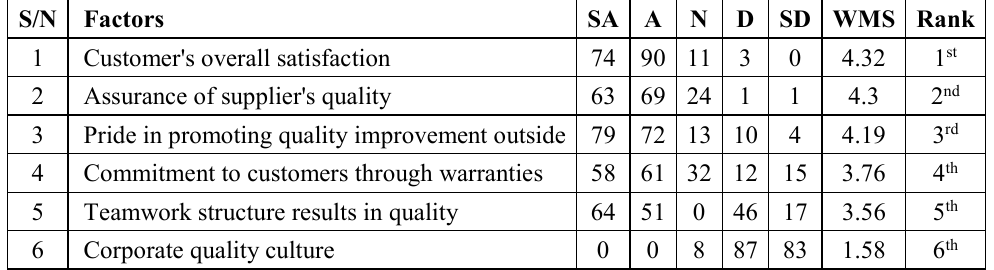
Table 3. Project Managers’ Perception of Quality Assurance